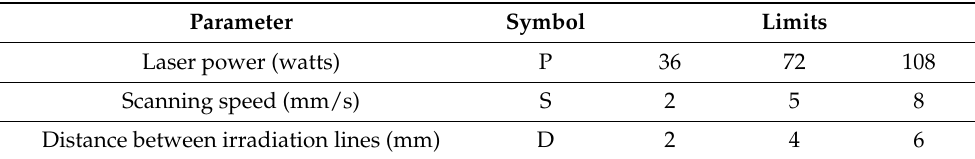
Table 1. The levels of parameters for LFP of cylindrical surfaces.